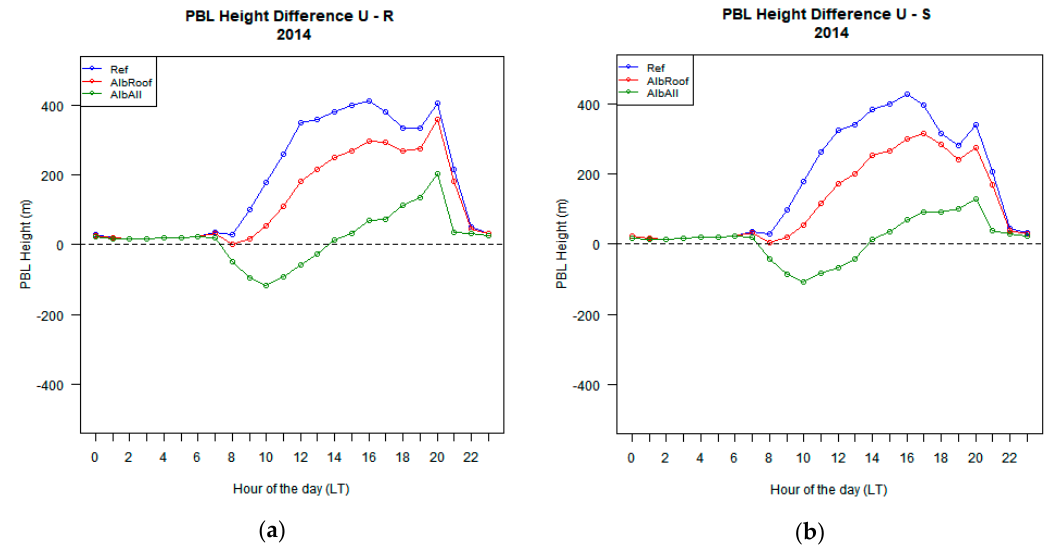
Figure 5. Same as Figure 3, but for Planetary Boundary Layer height (PBLH): ( a ) Average PBLH difference computed over the mixed forest land use (Rural) category in Figure 1; ( b ) Average PBLH difference computed over the croplands land use (Suburban) category in Figure 1.